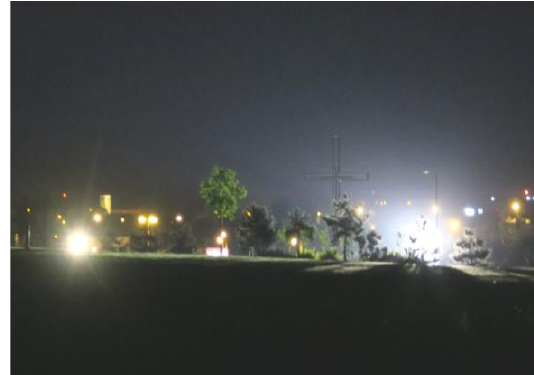
Fig. 3. Negative lighting of sacral object (yellow selection from fig. 2)